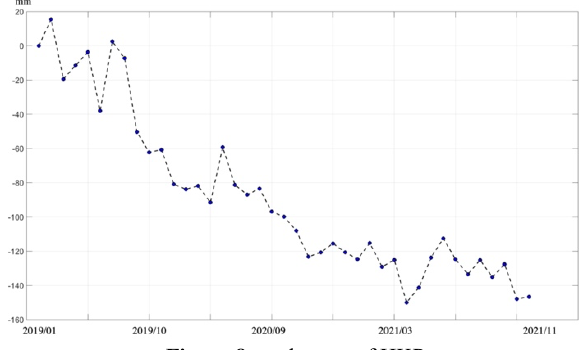
Figure 8 . settlement of HKP.